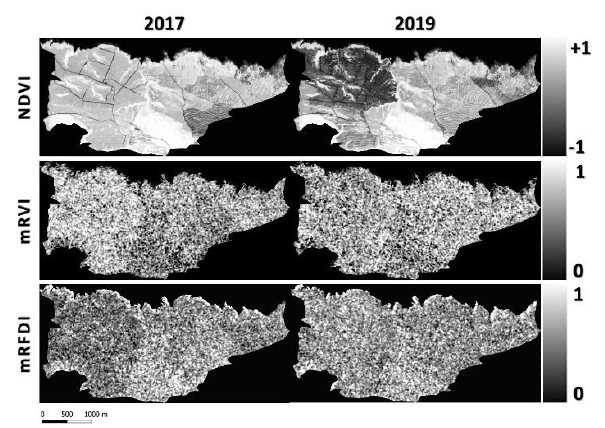
Figure 5. Vegetation indices for both 2017 and 2019 datasets.